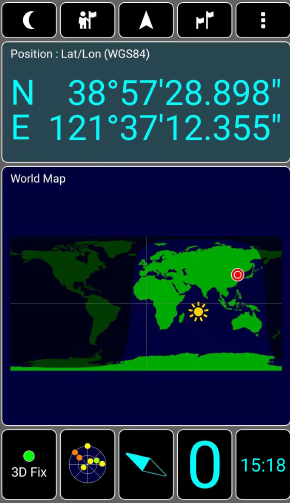
Figure 17. Physical position of test mobile